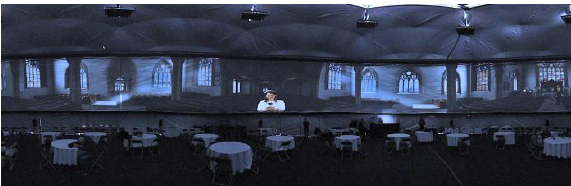
Figure 22 360º view of the interior of ICCI360 screen with the presentation of the 360º film about Charles